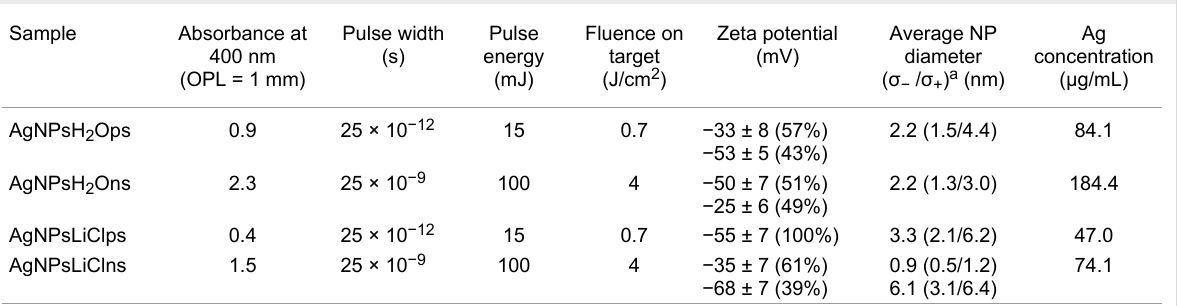
Table 1: Summary of AgNP colloids and of their characteristics.